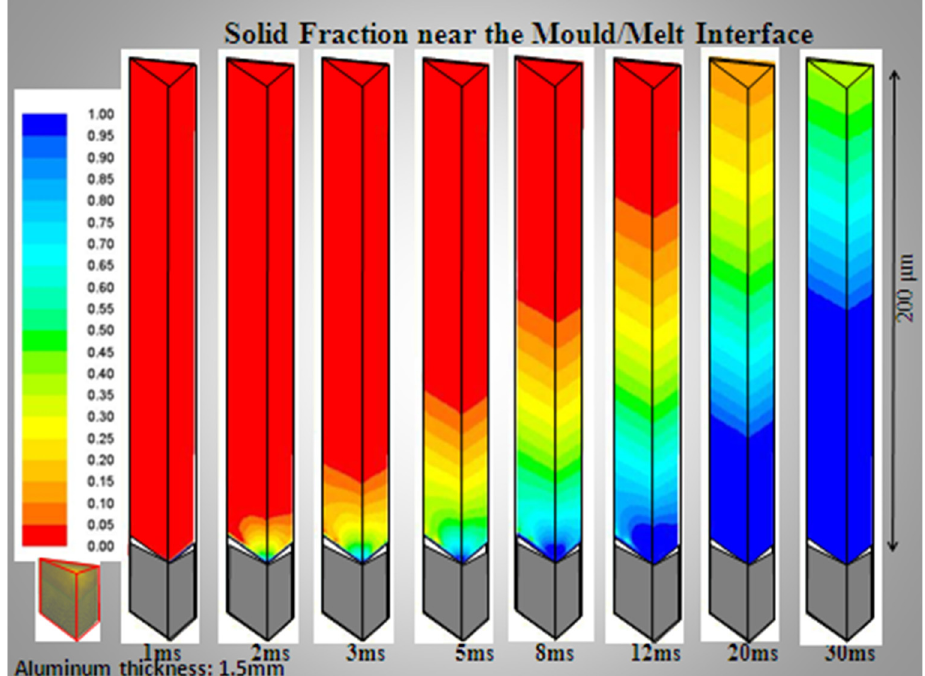
Figure 7. Ab initio computations of the first moments of solidification of an aluminum alloy, AA6111 strip, being cast, iso-kinetically, onto a 1 cm. thick copper substrate (depicted as a grey substrate). The idealized copper surface is modeled as an array of rectangular pyramids, whose peaks contact the melt at discrete points. The interfacial gas conducts the heat from the freezing metal into the copper substrate, as per our experimental results [13].